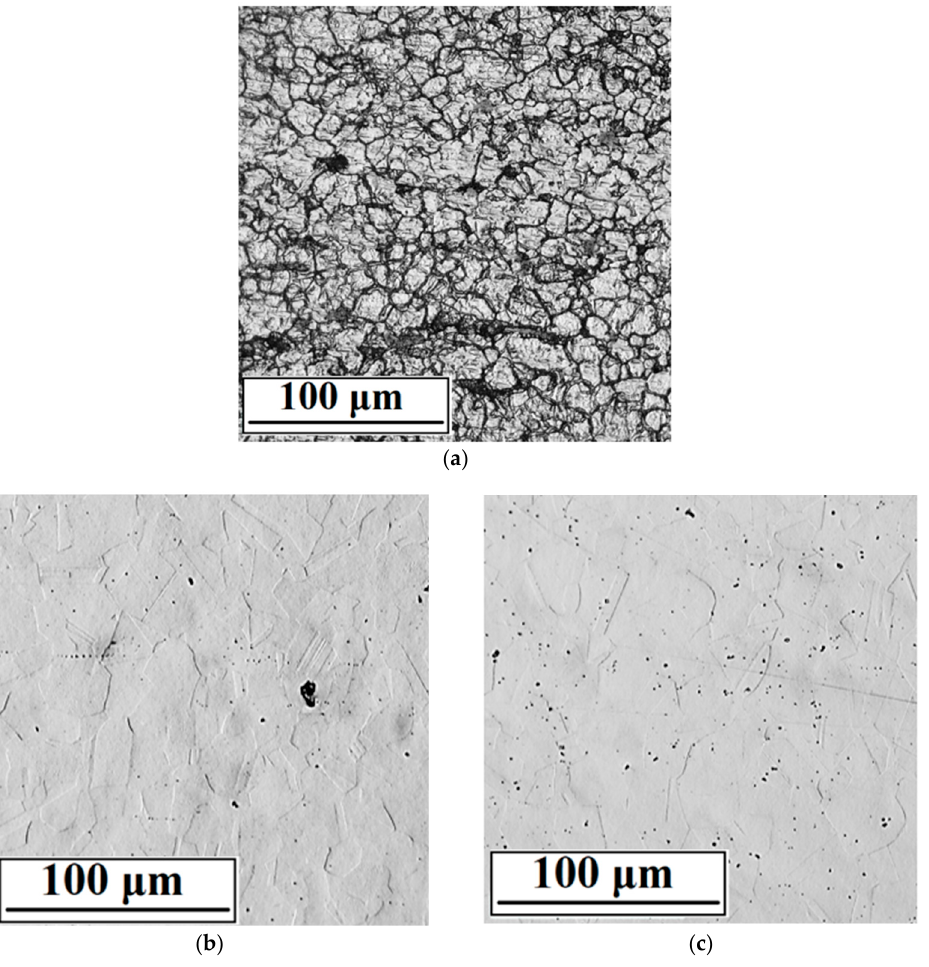
Figure 8. DOM surface morphology micrographs of surfaces after a 50-day exposition in 0.9 wt.% NaCl solution: ( a ) as received, ( b ) PEP, ( c ) PPEP (QBQ, magnification 600×). Table 7. Average corrosion rates calculated from mass losses during the exposure test.